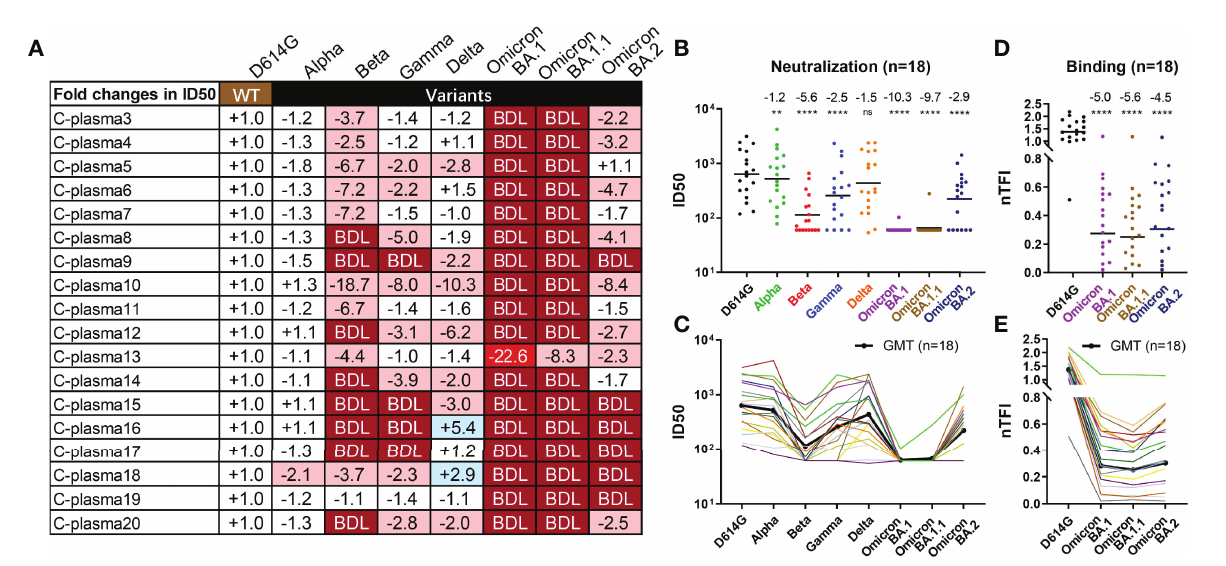
FIGURE 4 | Substantial reduction in neutralizing activity of convalescent plasma to Omicron variants. Reciprocal plasma dilutions (ID50) against SARS-CoV-2 variants are shown either by (A) fold changes relative to D614G pseudoviruses, or absolute values in (B) colored dots and (C) colored curves. The average fold changes in ID50 between each variant and D614G pseudoviruses are shown individually in (A) or as a group at the top in (B) . The symbol “ - ” indicates an increase in resistance while the symbol “ + ” indicates an increase in sensitivity. Those in light red indicate a minimum of 2-fold increase in resistance; dark red a minimum of 20-fold increase in resistance; blue a minimum 2-fold increase in sensitivity; and white a less than 2-fold change in either resistance or sensitivity. BDL (Below Detection Limit) indicates the highest concentration of plasma (1:60 for D614G, Alpha, Beta, and Gamma and 1:20 for Delta and Omicron) failed to confer 50% neutralization. (B, C) Each dot or curve represents a different plasma sample. The geometric mean titer of ID50 against each variant is indicated by a black solid line. (D, E) Plasma binding to spike proteins on the cell surface measured by FACS and presented as normalized total fl uorescent intensity (nTFI) in (D) colored dots and (E) colored curves. The results were calculated from two independent experiments, and each included two experimental replicates. **P < 0.01; and ****P < 0.0001. ns, not signi fi